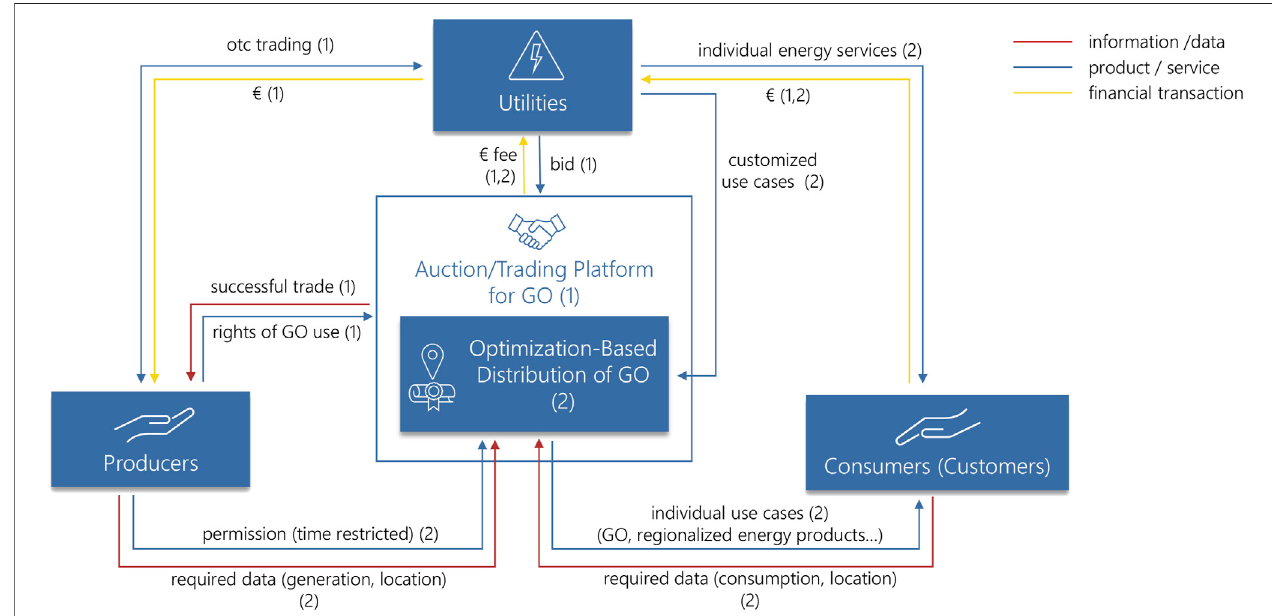
FIGURE3 | e 3 -value model describing theinteractions ofapotentialauction platform for GO, divided into exante trading (1)and expost optimized GO distribution (2), adapted according to Bogensperger and Zeiselmair (2020).